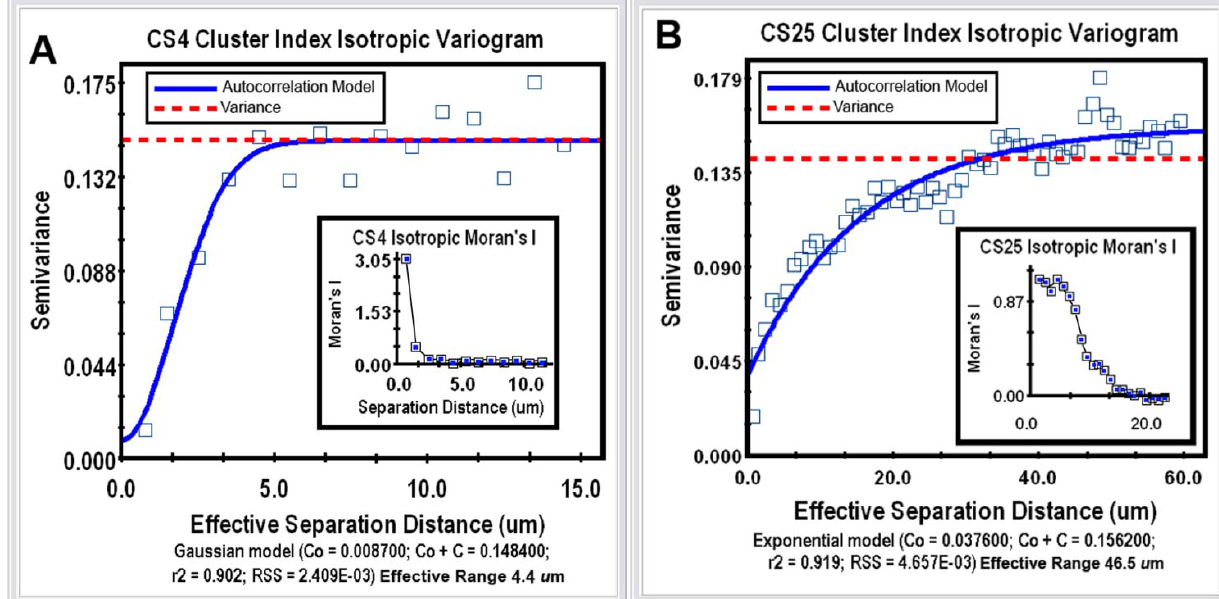
Figure 5. Isotropic semivariograms of the spatially autocorrelated cluster indices of cells in the CS4 ( A ) and CS25 ( B ) biofilm assemblages. Note the greater effective separation distance (95% of the asymptote) and Moran’s Index (inserted plots) for cells in the CS25 biofilm, indicating that they have a stronger autocorrelated intensity of clustered distribution pattern and are positively interacting over a wider radial in situ spatial